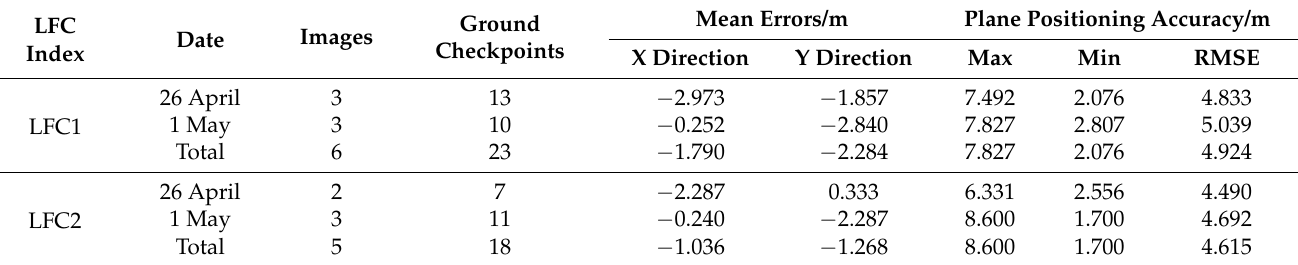
Table 6. Validation results for external calibration with multi-orbits.